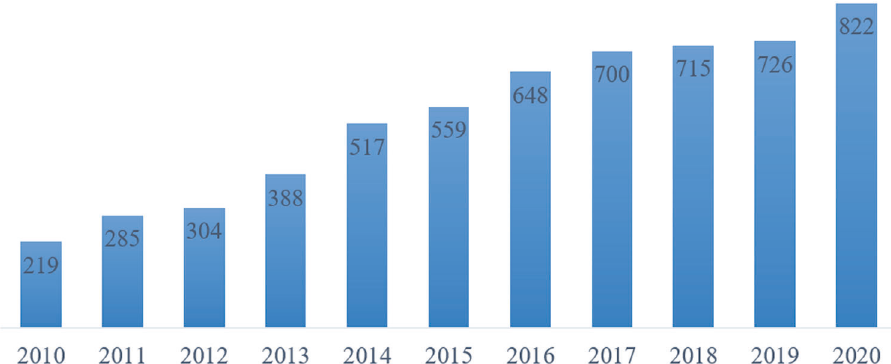
Fig. 1 Number of studies published annually in the past decade. The studies were retrieved from PubMed using key words « “ working memory ” , training